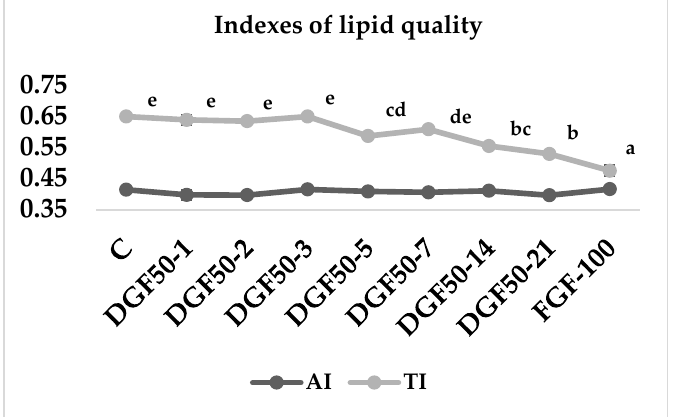
Figure 3. Atherogenic index (AI) and thrombogenicity index (TI) of Tenebrio molitor larvae fed with fish-based diets. The same letter is not significantly different from one another ( p < 0.05).